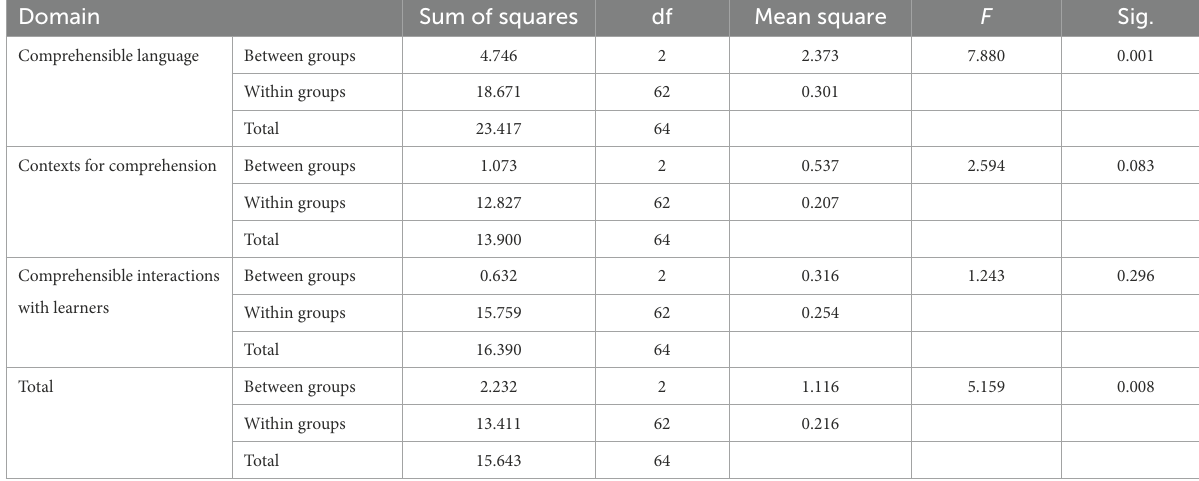
TABLE 8 One-way ANOVA variance analysis.